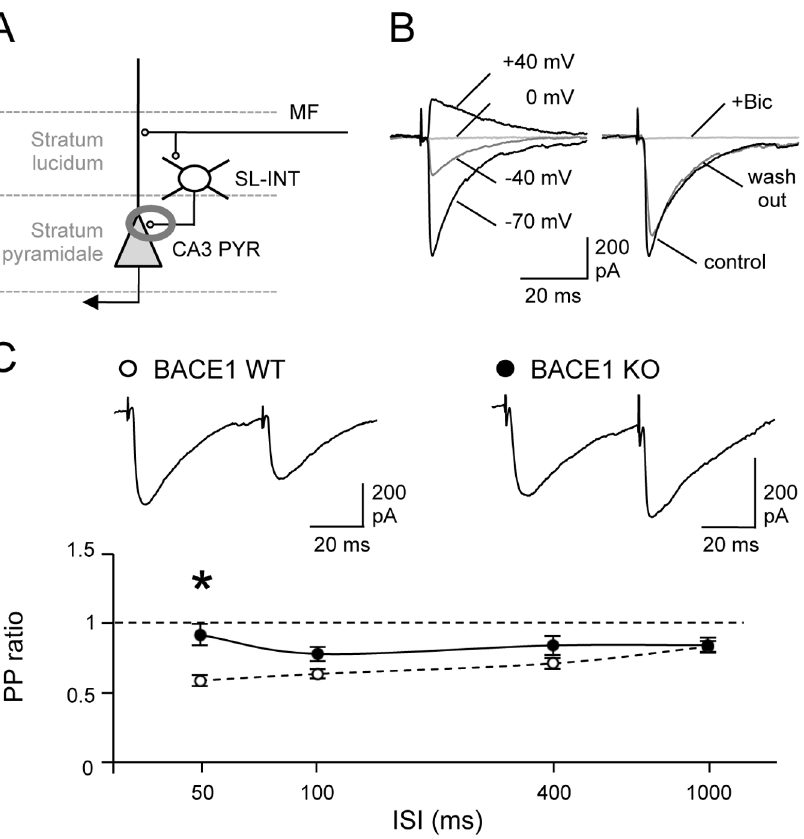
Figure 4. Increased paired-pulse ratio of eIPSCs from SL-INTs to CA3 PYRs in BACE1 KOs. (A) A diagram showing the inhibitory input from SL-INTs to CA3 PYRs. (B) Left: Verification that the internal solution we used reversed evoked IPSCs at 0 mV. Each evoked IPSC trace was recorded under different holding voltage as indicated. Right: The pharmacologically isolated eIPSCs were blocked by addition of 20- m M bicuculline ( + Bic, gray trace), and the currents were reversible when bicuculline was washed out. (C) Paired-pulse depression was impaired in BACE1 KOs (black circles) especially at 50 msec ISI compared to WTs (white circles). Top panel: Representative evoked IPSC traces from CA3 PYRs following paired-pulse stimulation at 50 msec ISI. *P , 0.001, two-way ANOVA; Fisher’s PLSD post hoc test P , 0.001 between the two